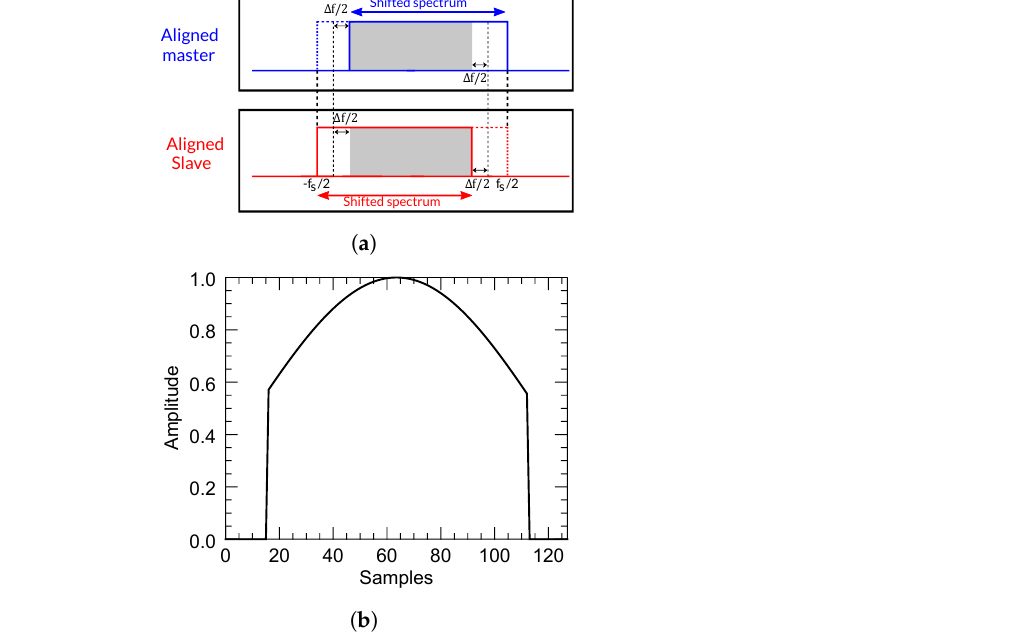
Figure 8. Low-pass spectral filtering after alignment of master and slave images. A spectral displace- ment of 30 samples is assumed. ( a ) Spectral alignment of master and slave images. ( b ) Spectral shape of the low-pass filter:a Kaiser window of 128 samples.